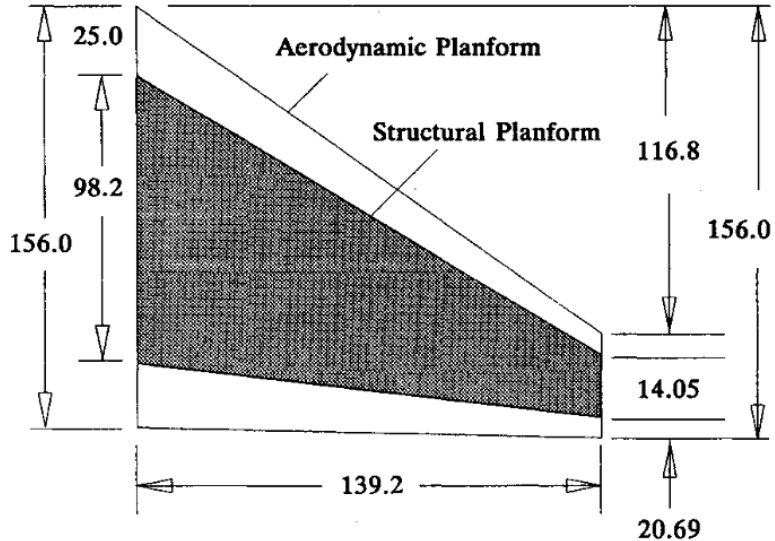
Figure 8. Full ‐ scale wing of aerodynamic, Adapt with permission from [51]. Figure 8. Full-scale wing of aerodynamic, Adapt with permission from